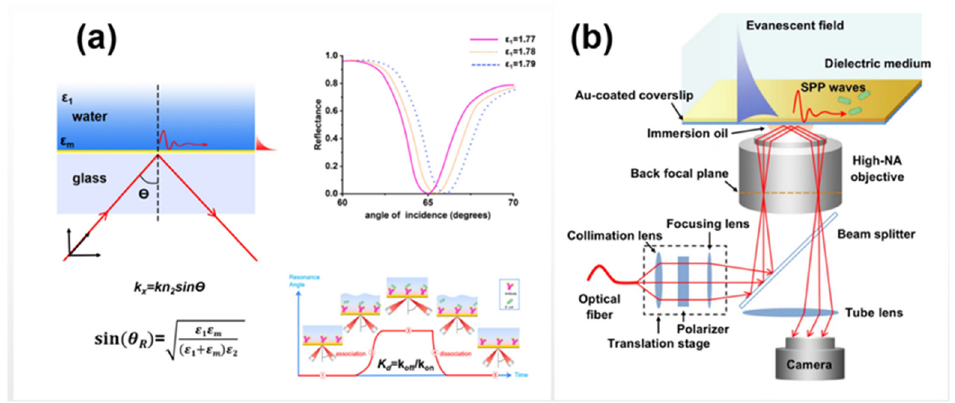
Figure 1. Schematic diagrams of ( a ) SPR optical system and ( b ) SPR